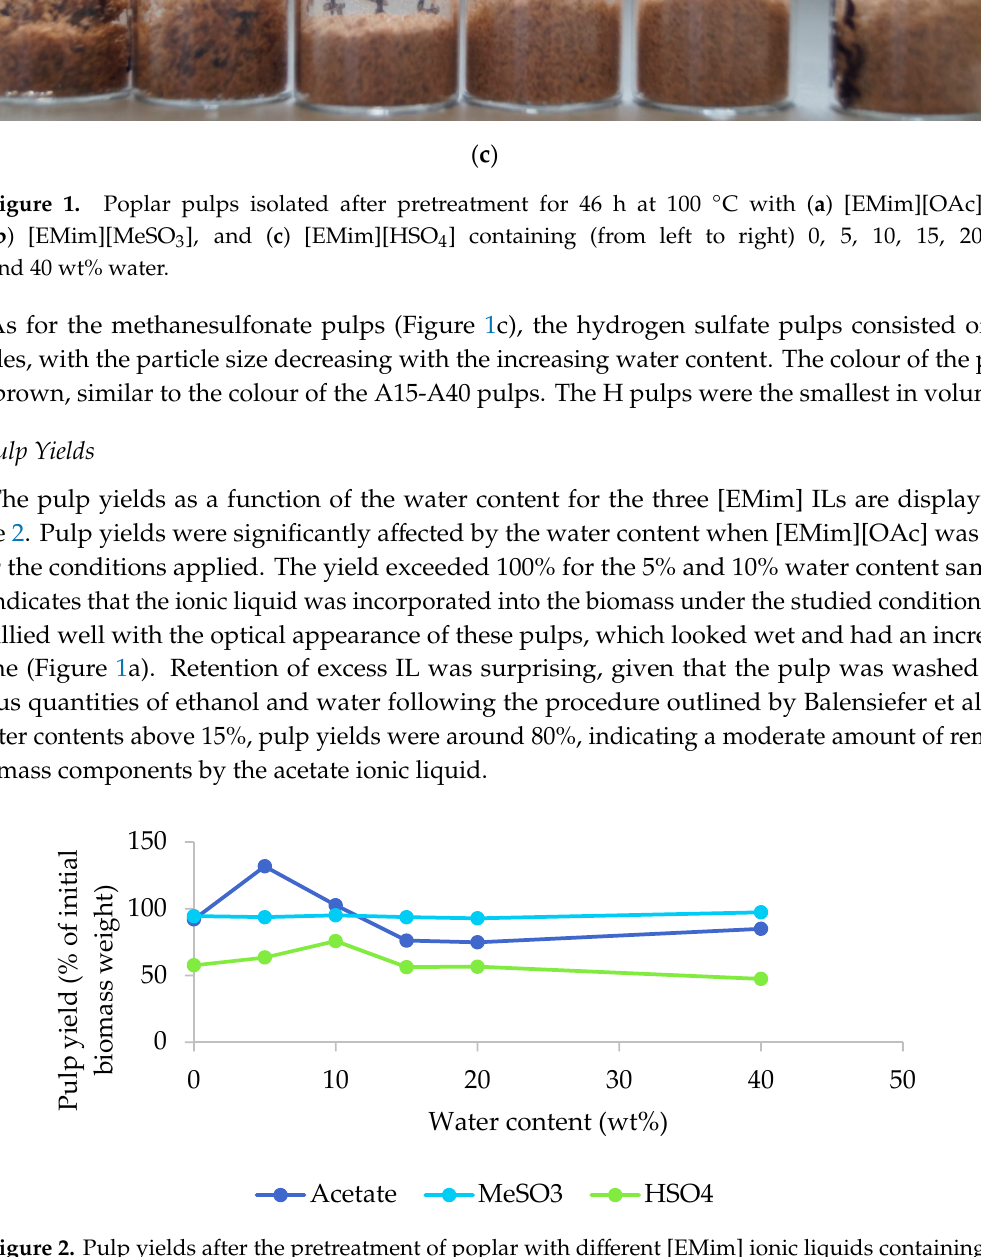
Figure 2. Pulp yields after the pretreatment of poplar with different [EMim] ionic liquids containing 0–40 wt% water for 46 h at 100 °C.